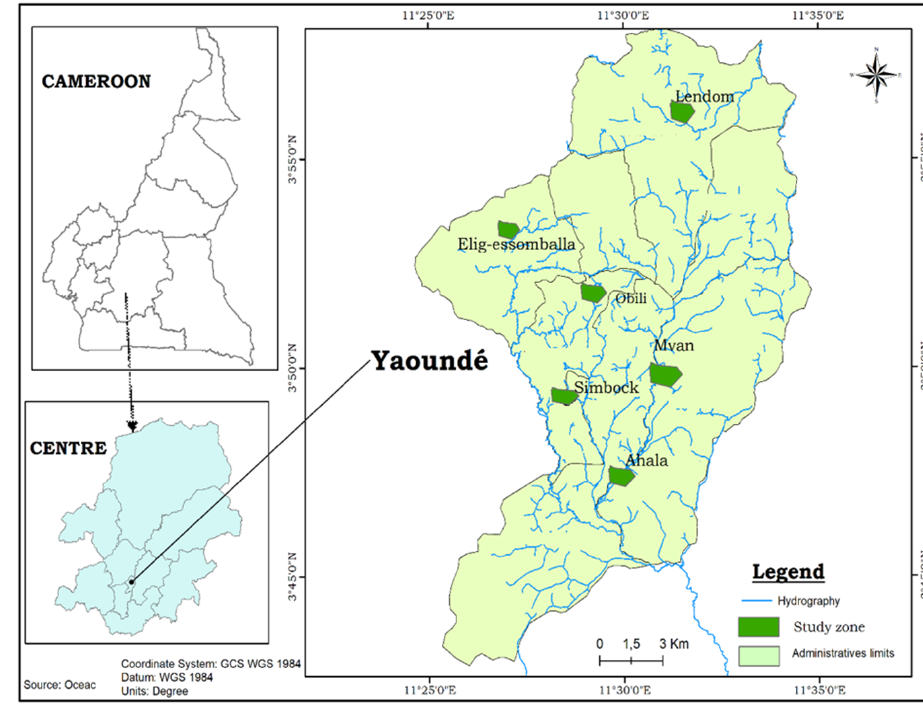
Figure 1. Map of the city of Yaoundé showing the study sites.